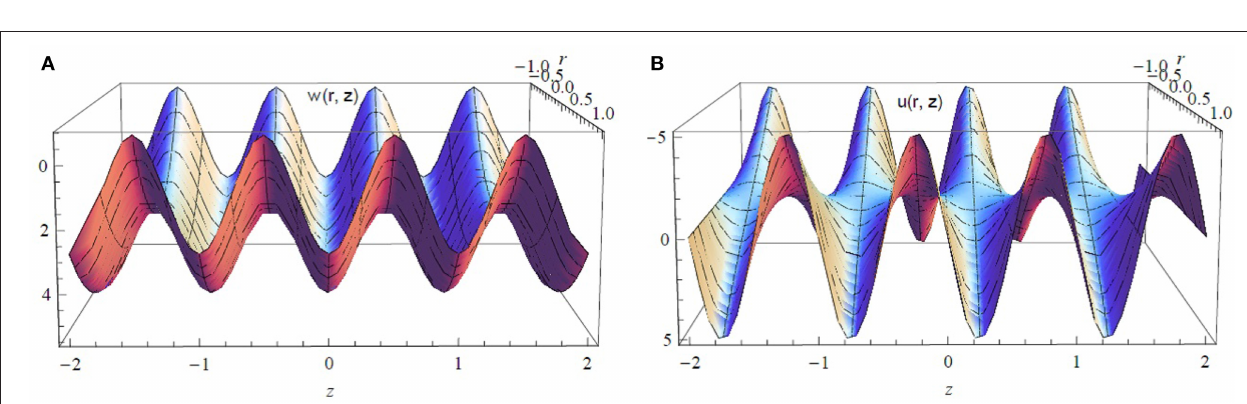
FIGURE 6 | (A) Axial and (B) radial components of the velocity vector for ǫ = 0.2, α * = β * = 0.7, and ¯ Q =